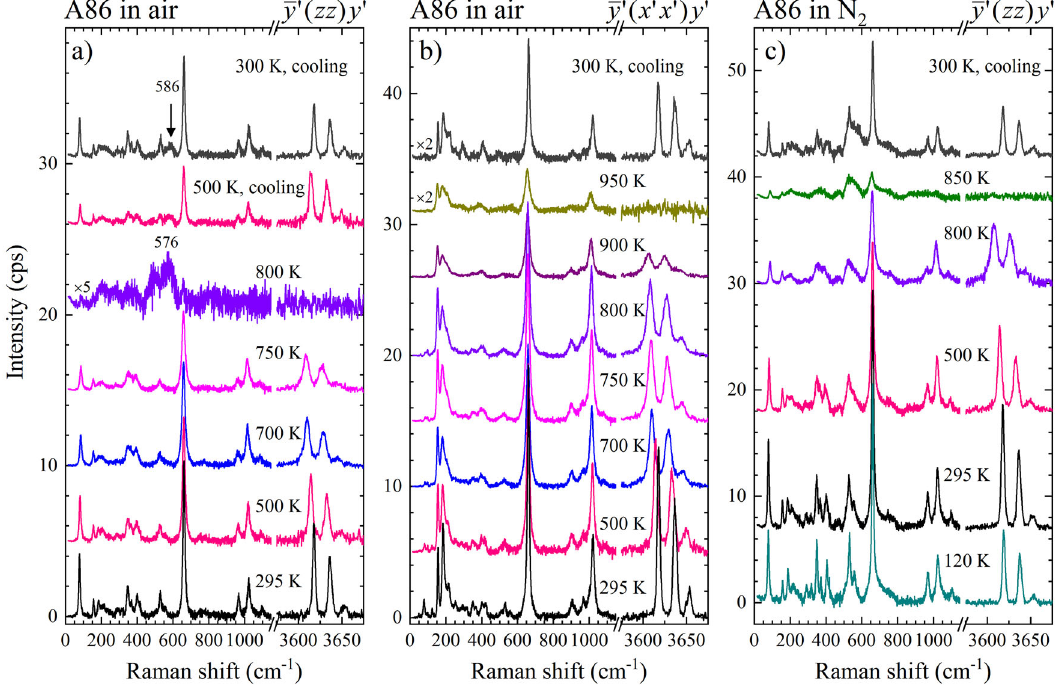
Fig. 7 Temperature-dependent Raman spectra of grunerite A86 measured in situ. a Data collected in air in (cid:1) y 0 ð zz Þ y 0 scattering geometry; b data collected in air in (cid:1) y 0 ð x 0 x 0 Þ y 0 scattering geometry; c data collected in N 2 in (cid:1) y 0 ð zz Þ y 0 scattering geometry. Spectra are vertically offset for